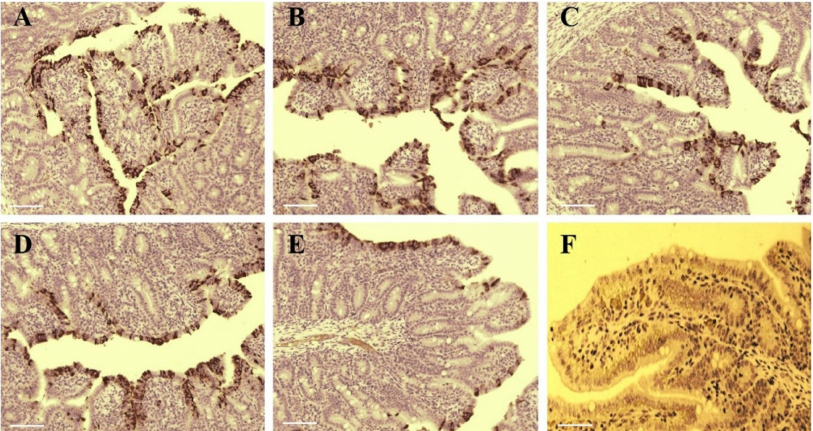
Figure 6. The tissues of infected PEDV SDSX16 isolate strain and uninfected groups were intestine histologically examined. ( A – E ) were infected withSDSX16-P10, -P30, -P63, -P64, and -P75, respectively. The immune-histochemical method was used to detect positive infection cells present signal in a segment of the intestines. ( F ) was the uninfected group from control animals, and there was no significant change. Scale bar represents 50 µ